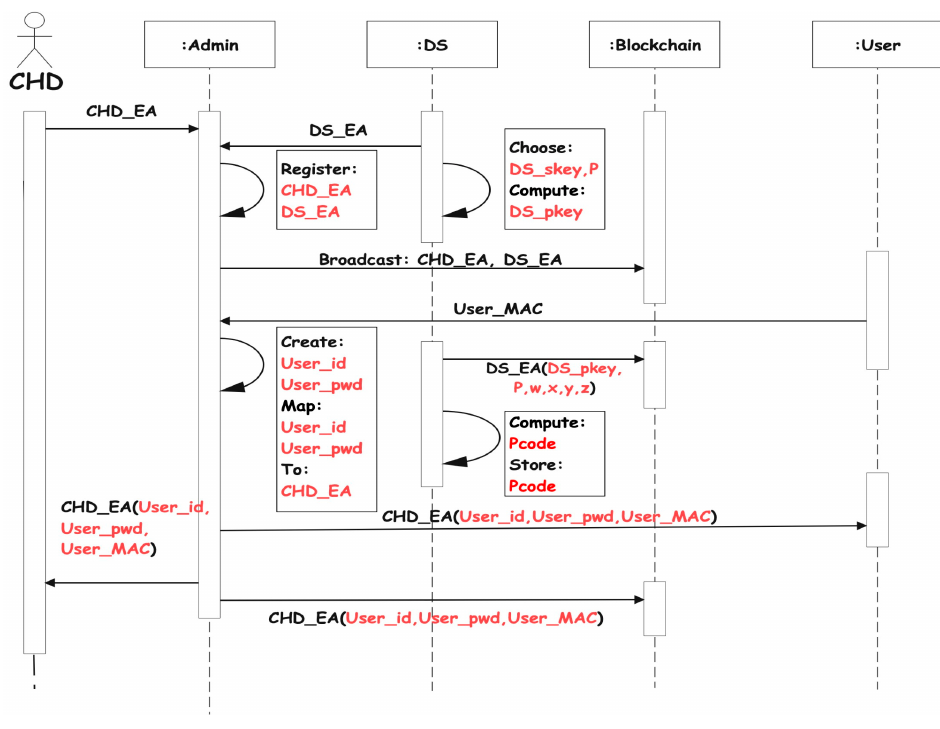
Figure 2. IPChain registration stage.